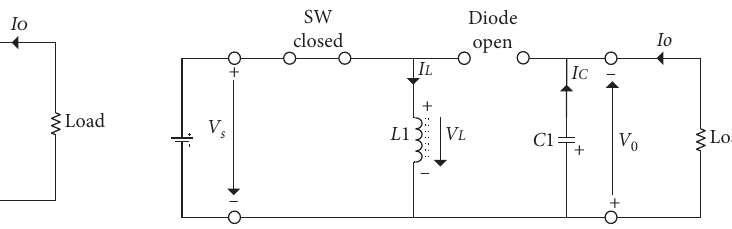
Figure 1: Buck-boost converter circuit.